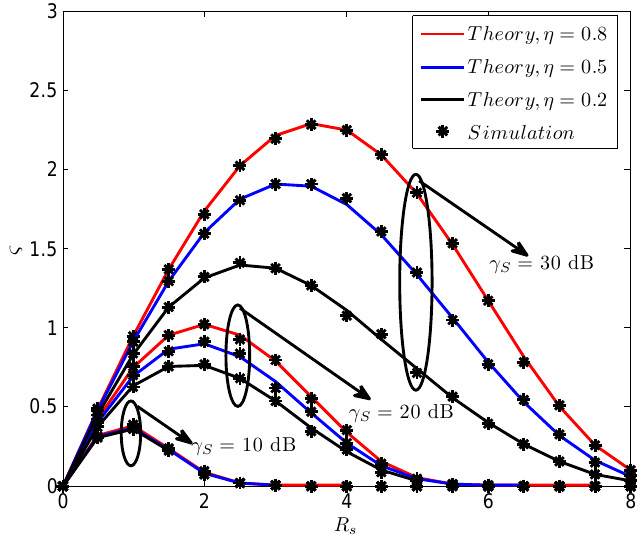
Figure 5. P out vs. R s with different γ S and η . γ S = 30 dB, ¯ γ SD = ¯ γ DD = 5 −